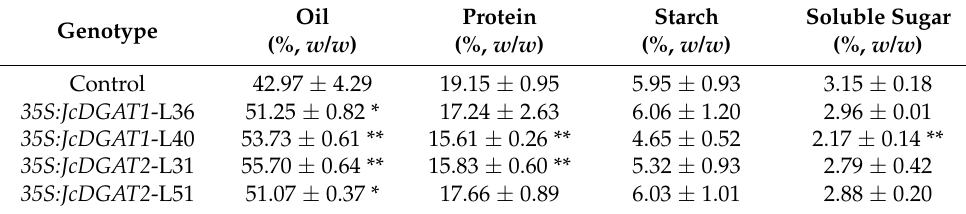
Figure 3. Seed kernel oil contents and dry weights in control and 35S:JcDGATs transgenic lines. (A) Total kernel oil content. (B) Dry weight of 10 seeds. The values are presented as the means ± standard deviations of three independent biological replicates. The student’s t-test was used for statistical analyses. * p ≤ 0.05, ** p ≤ 0.01. Table 1. Content of major metabolites in the seed kernels from the control and 35S:JcDGATs transgenic J. curcas plants.